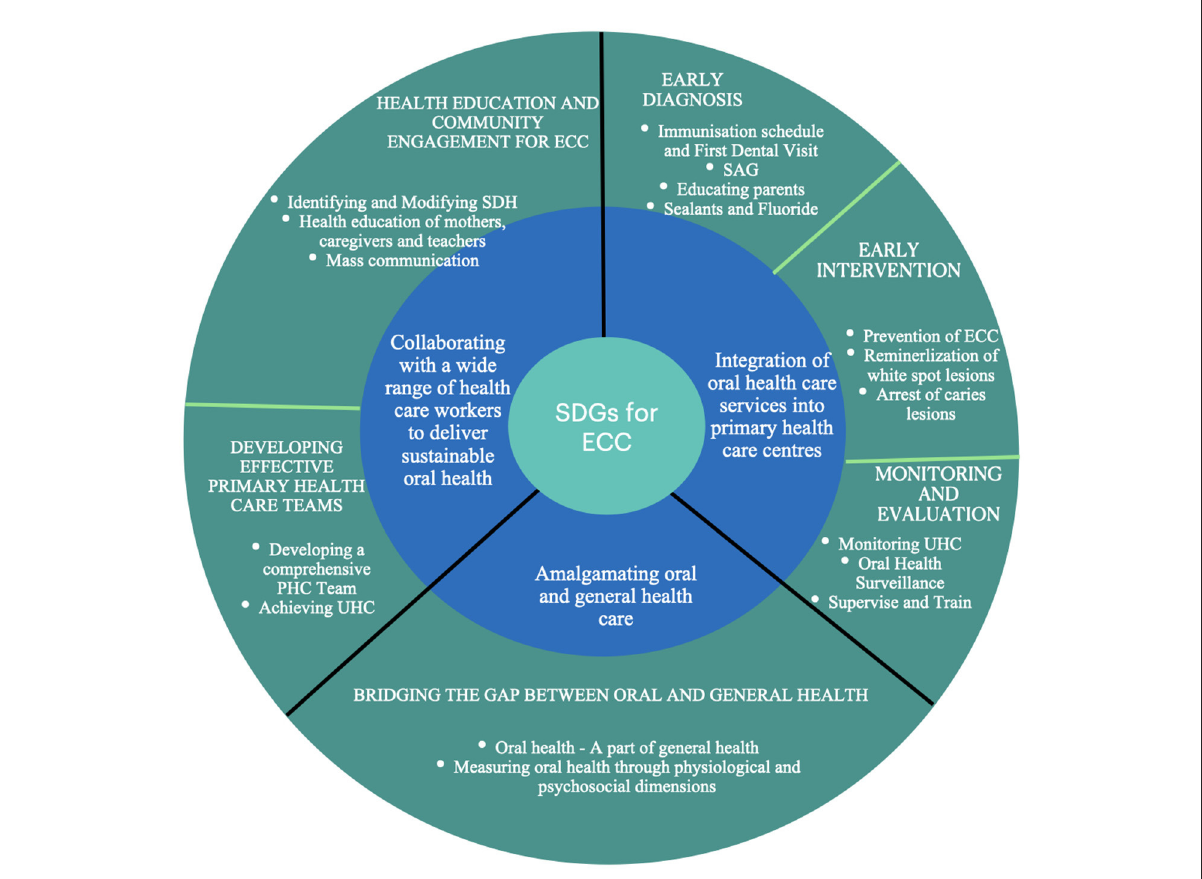
FIGURE4 Proposed SDGs for ending ECC.